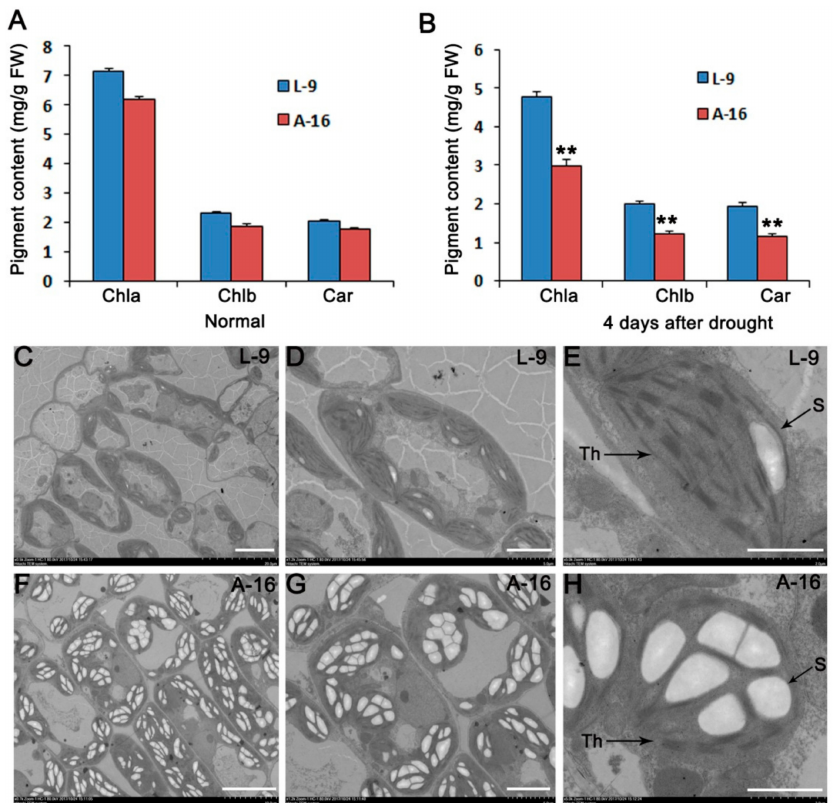
Figure 2. TEM observation of L-9 and A-16 leaves at seedling stage. ( A ) Chlorophyll content of L-9 and A-16 before drought. ( B ) Chlorophyll content of L-9 and A-16 during drought. Data is presented as the mean ± standard deviation ( n = 9). ** p < 0.01; Student’s t -test. ( C – H ) Transmission electron microscopic photos of cells from L-9 and A-16. ( C – E ) Mesophyll cells in L-9 plants showed normal, well-ordered chloroplasts. ( F – H ) Cells in A-16 plants displayed some abnormalities and accumulated starch grains.